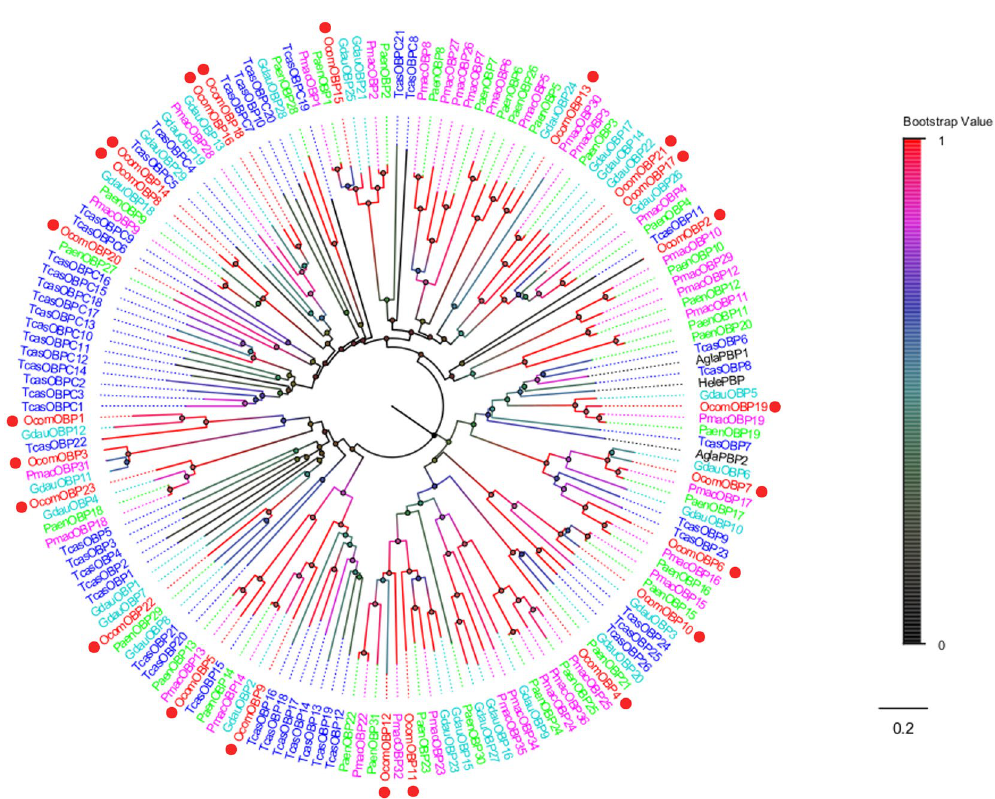
Figure 2. Neighbor joining phylogenetic tree of candidate OcomOBPs with known Coleopteran OBP sequences. Tcas, Tribolium castaneum (N = 47); Pmac, Pyrrhalta maculicollis (N = 33); Paen, Pyrrhalta aenescens (N = 31); Gdua, Galeruca daurica (N = 29); Agla, Anoplophora glabripennis (N = 2); Hele, Hylamorpha elegans (N = 1). Candidate OcomOBPs were indicated by red